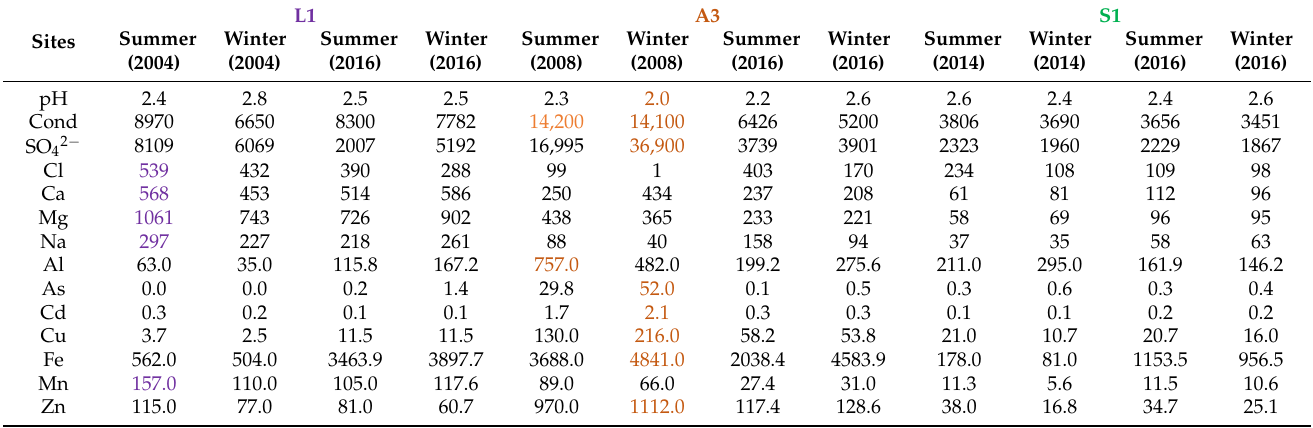
Table 2. Physicochemical parameters and their concentrations (mg/L) in the acid sampling points L1, A3 and S1 in previous studies (summer and winter of 2004 [34], 2008 [16] and 2014 (unpublished results), respectively) and in this study (summer and winter of 2016) for comparison. Conductivity was measured in µ S/cm. (color code for highest concentrations of the parameters in the